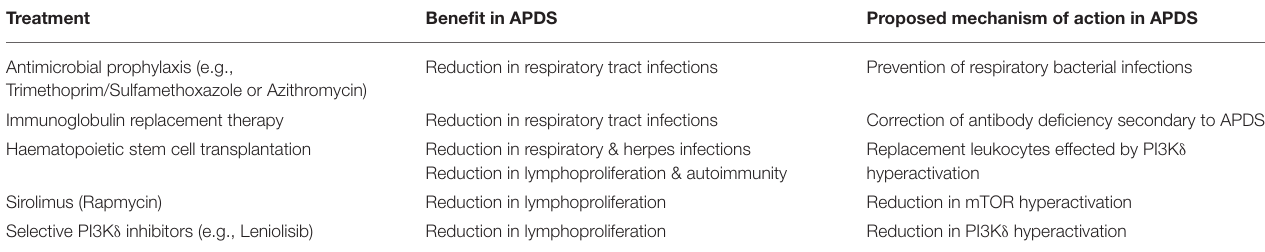
TABLE 1 | Treatment options in Activated PI3K δ Syndrome